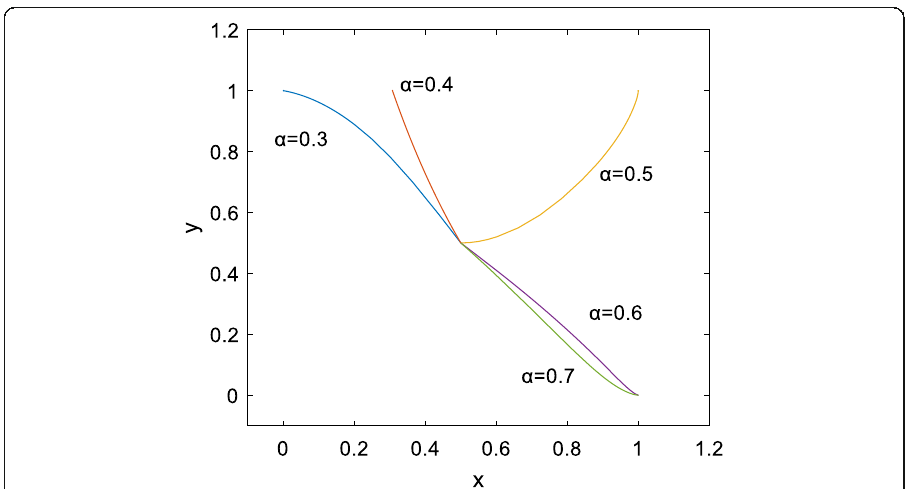
Fig. 9 Evolutionary game of the system with different distribution coefficients. Source: Authors ’ processing using